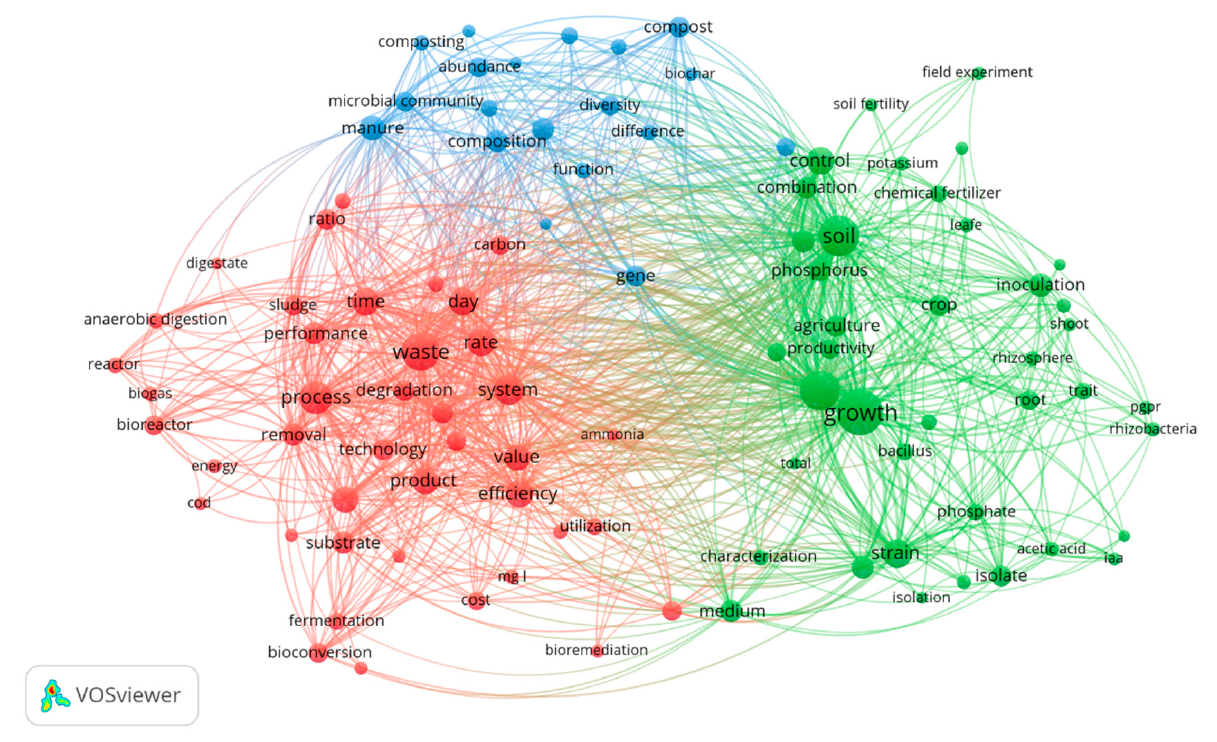
Figure 6. Visualisation of critical terms co-occurrence in textual data used in fertilizer research. The terms in the three groups could be classified as given in Table